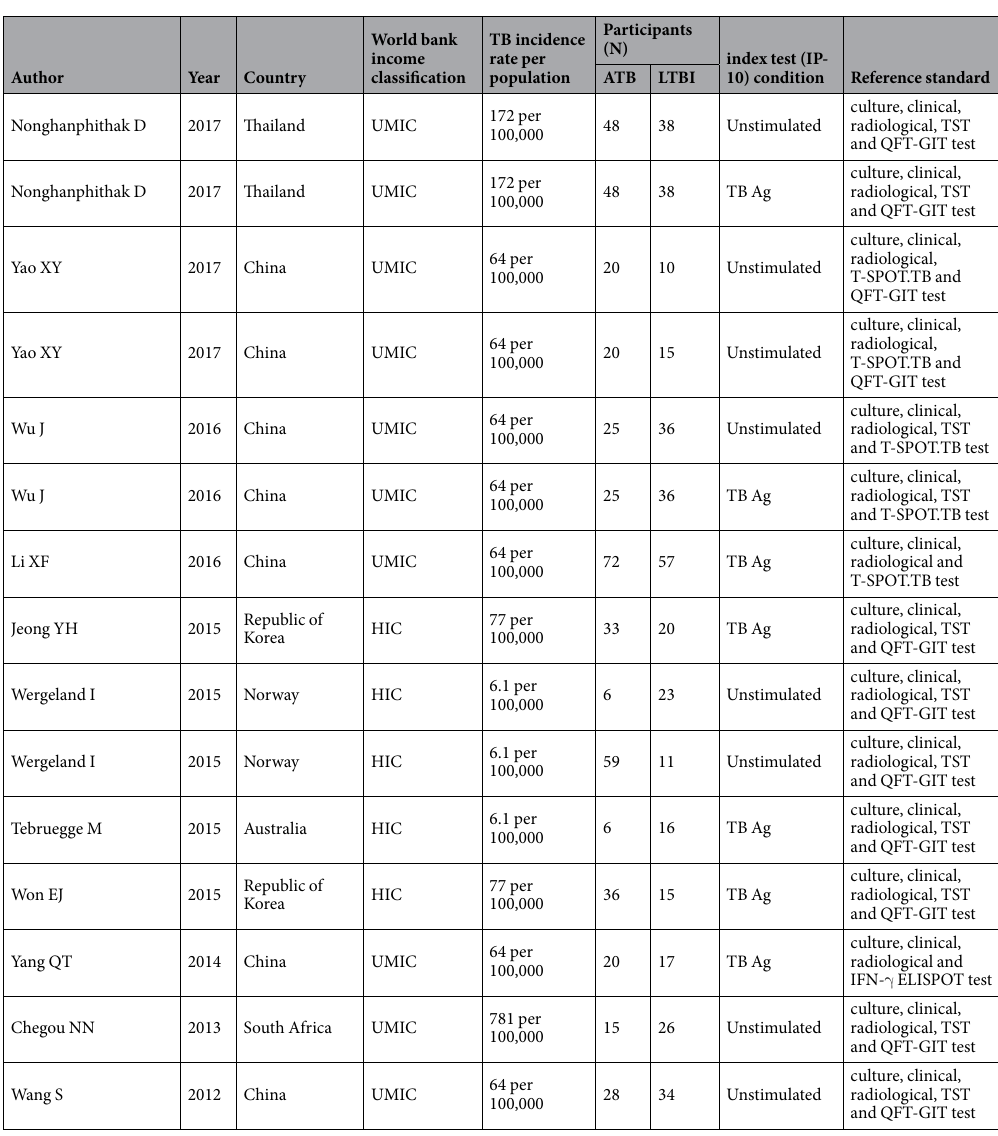
Table 1. Main characteristics of studies included in the meta-analysis. UMIC: upper-middle-income countries, HIC: high-income countries, TB Ag: tuberculosis antigen, TST: tuberculin skin test, QFT-GIT: QuantiFERON-TB Gold In-tube, ELISPOT: enzyme linked